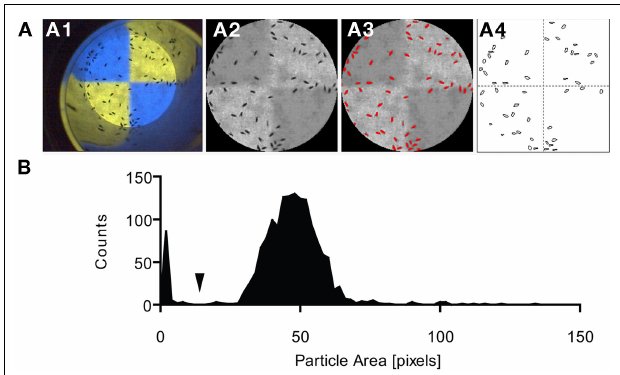
FIGURE 4 | Semi-automatic fl y counting. Using ImageJ, fl ies in every region of interest (e.g., quadrant) were counted in every frame (automated using a macro). (A) The raw image (A1) was trimmed by manually selecting the test arena, and the image was gray-scaled (A2) . A threshold was set to separate the fl ies from the background ( A3 ; recognized objects marked in red). The “Analyze Particles” function was used to count the objects in each quadrant and frame (A4) . (B) Histogram of the particle area distribution on a quadrant of one test video. Particles smaller than a certain size (arrow) were regarded as non-fl y particles and excluded from